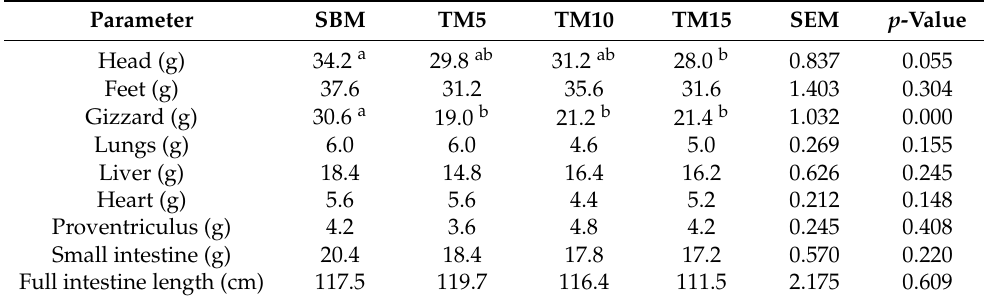
a,b Means in the same row not sharing a common superscript are different ( p < 0.05). Diets: SBM = soybean meal, TM5% = a diet in which 5 g/kg of soybean was replaced with Tenebrio molitor meal, TM10% = a diet in which 10 g/kg of soybean was replaced with Tenebrio molitor meal. TM15% = a diet in which 15 g/kg of soybean was replaced with Tenebrio molitor meal. SEM: standard error of the mean. The slaughter rate is one of many factors affecting the value of a slaughter animal. The indexes of slaughter rate are presented in Figure 1 and were calculated by dividing the weight of carcass by live weight and multiply by 100. The carcass rate was higher in the TM15 group followed by control group (SBM). There were slight variations in the percentages of other meat potions.